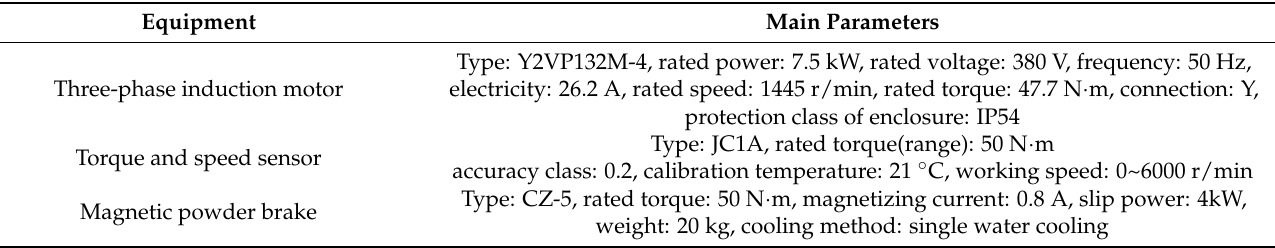
Figure 19. The experimental measuring points: ( a ) measuring point 1, ( b ) measuring point 2, ( c ) measuring point 3, ( d ) measuring point 4, ( e ) measuring point 5, ( f ) measuring point 6. Table 5. The main parameters of the